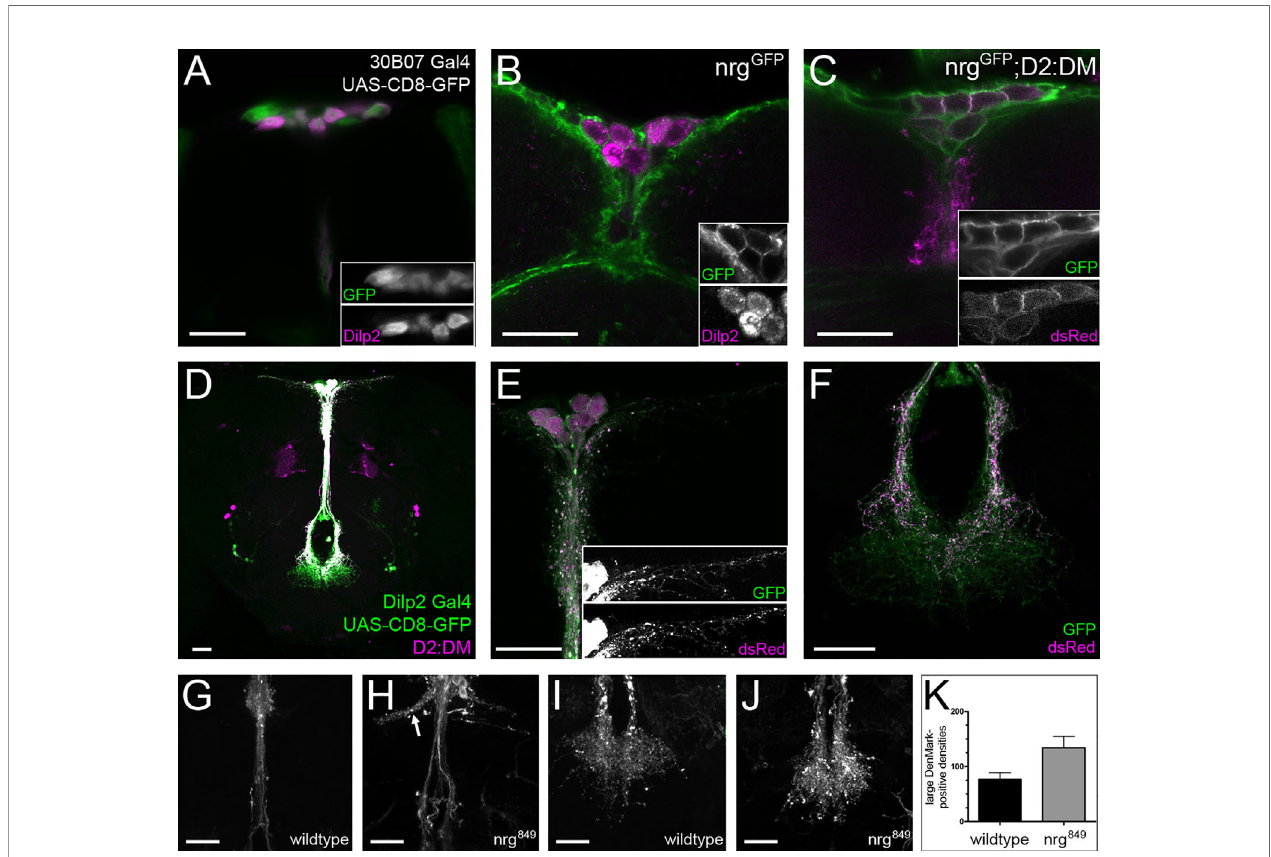
FIGURE 1 | nrg is expressed in insulin-producing cells and required for their differentiation. (A) The Nrg Gal4 reporter 30B07 is expressed in the IPCs, as shown with double-labeling with anti-GFP (green) and anti-Dilp2 (magenta) (B, C) Expression of Nrg ( a -GFP, green) can be seen in nrg GFP brains in the IPCs, labeled with Dilp2 (magenta) as well as with the D2:DM IPC marker ( a -dsRed, magenta). (D – F) The D2:DM marker ( a -dsRed, magenta) is coexpressed in the IPCs with Dilp2 Gal4 > UAS-CD8-GFP ( a -GFP, green). (G, H) The IPCs of nrg 849 mutants display defasciculation and ectopic branching phenotypes (marked by the arrow) as well as (I-K) a signi fi cant increase in the number of large DenMark-positive densities (unpaired t-test: P=0.027; wildtype, mean = 76.36 ± 12.61, n = 11; nrg 849 , mean = 134.1 ± 20.66, n = 11). Adult brains were used in all panels. Scale bars = 20 m